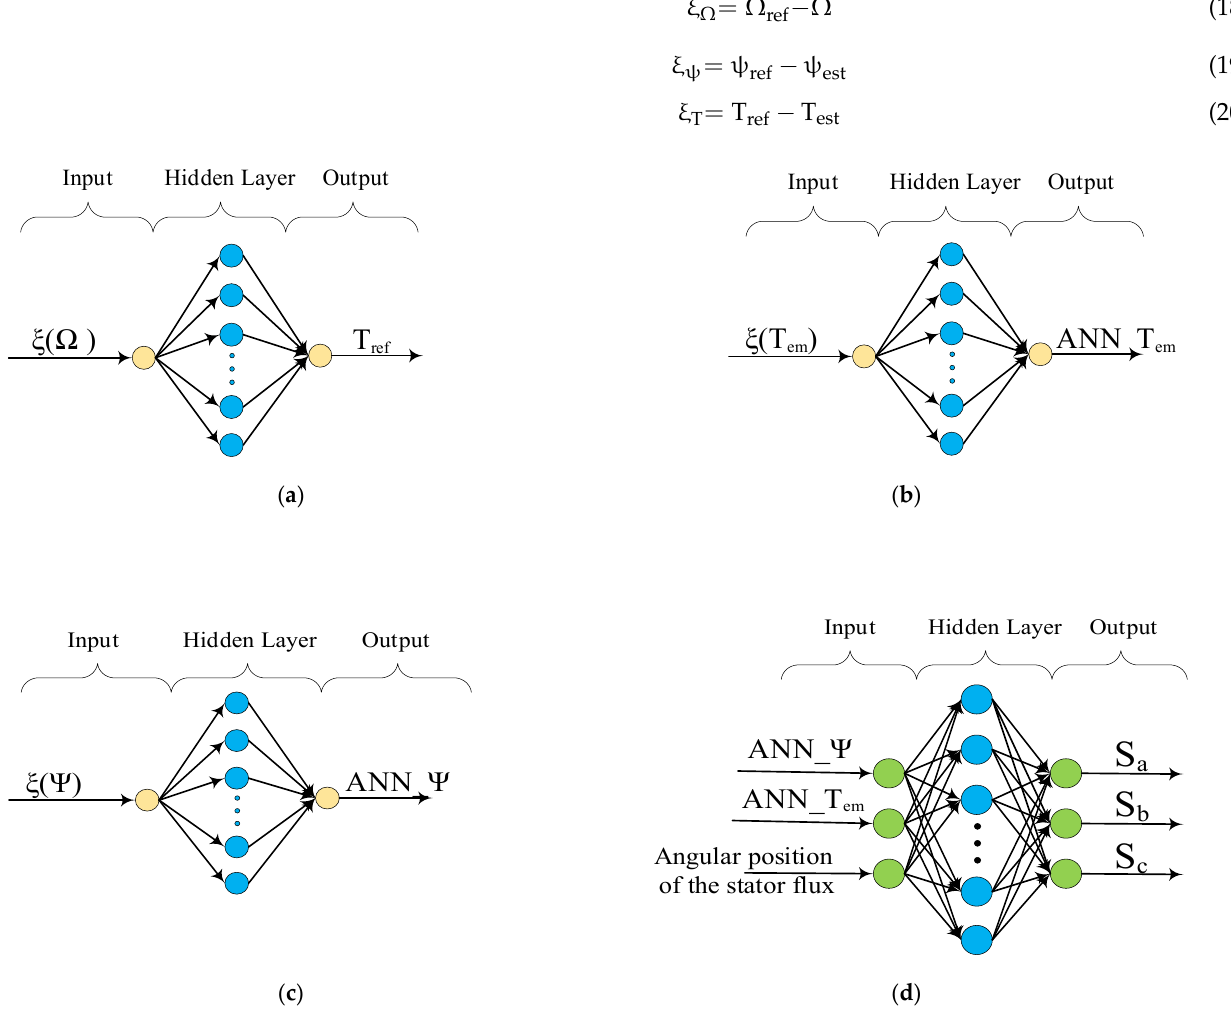
Figure 8. ANNs for: speed controller ( a ), torque controller ( b ), stator flux controller ( c ), switching table ( d ).